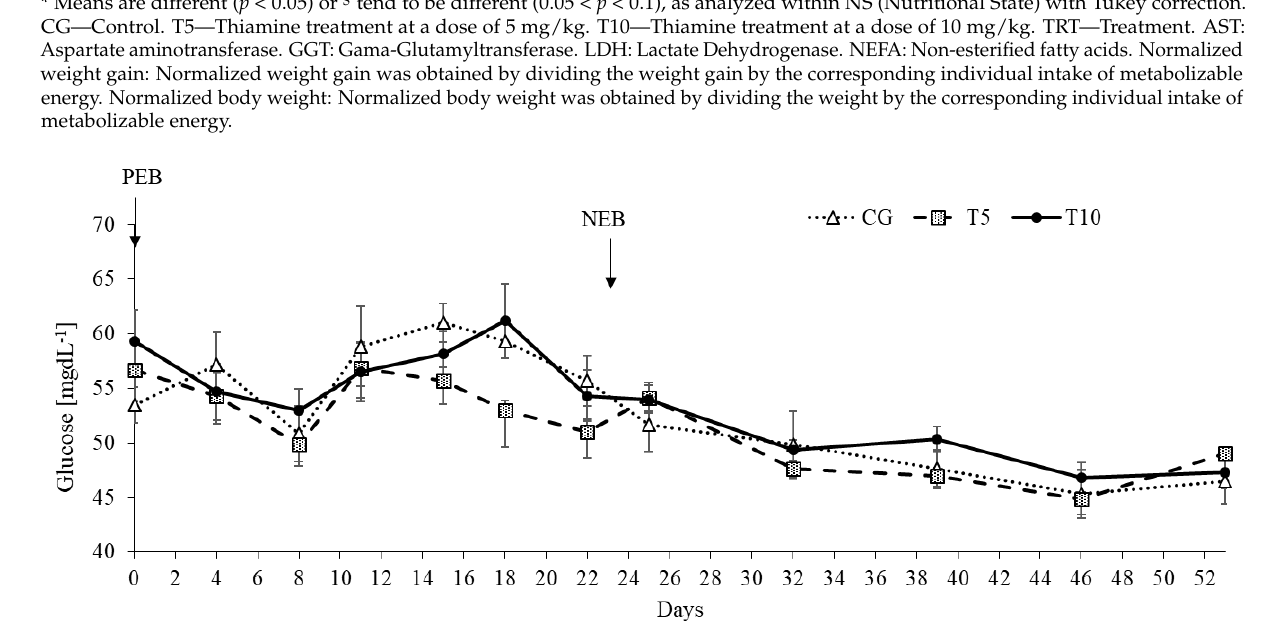
Table 1. Serum parameter, body weight, and non-esterified fatty acids (NEFA) analysis of the control (CG) and the thia- mine treated sheep under positive and energy balance nutritional states. Positive Energy Balance Negative Energy Balance Parameter